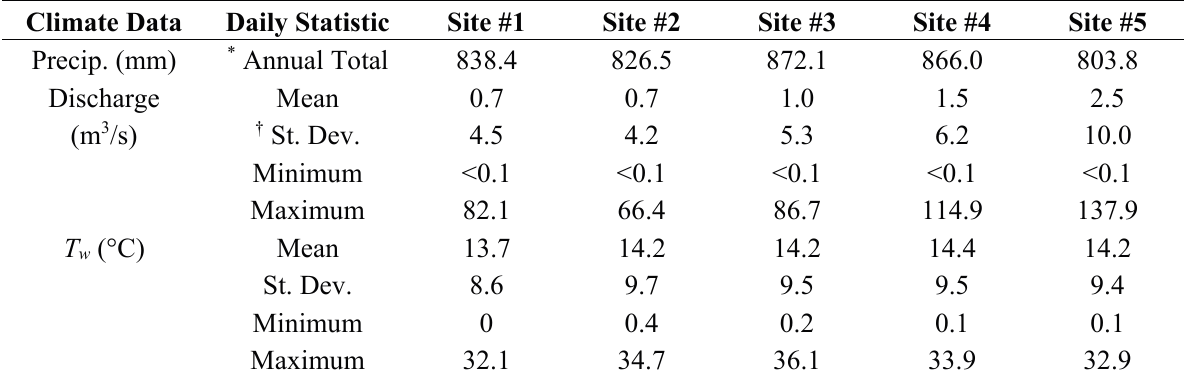
Table 3. Summary of statistics during the study period (WY 2011–2013) for five hydroclimate stations located in Hinkson Creek Watershed, Missouri,